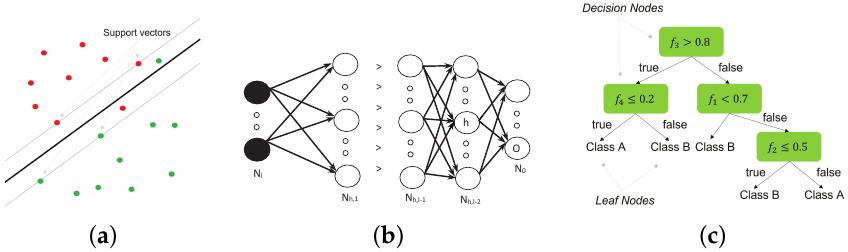
Figure 7. ( a ) SVM classifier. ( b ) MLP with l layers. ( c ) Decision tree example